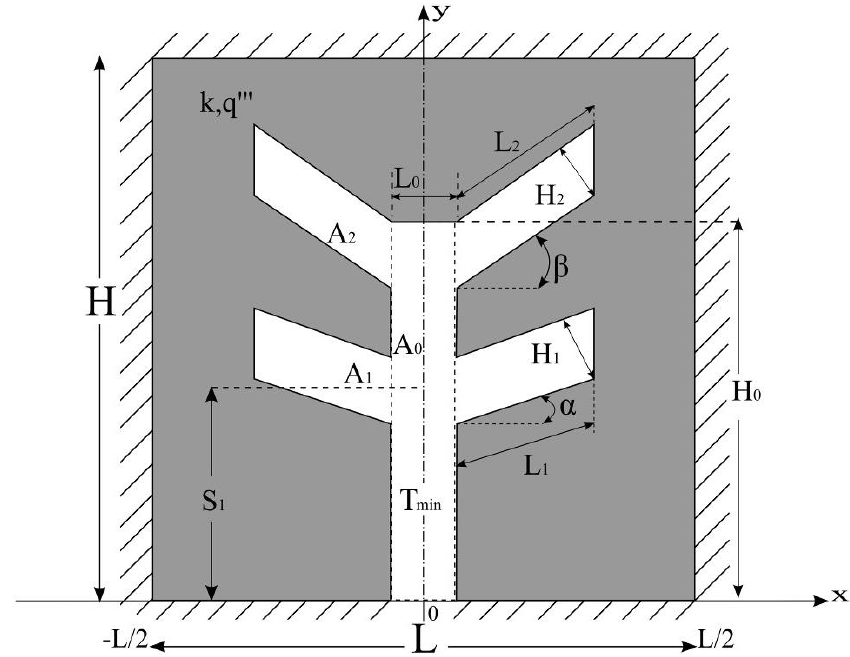
Figure 1. Computational domain of the double Y-shaped cavity.